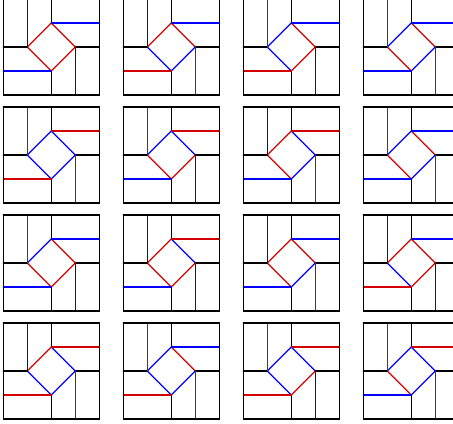
Fig. 7. The 16 possible square twists given Theorem 3.